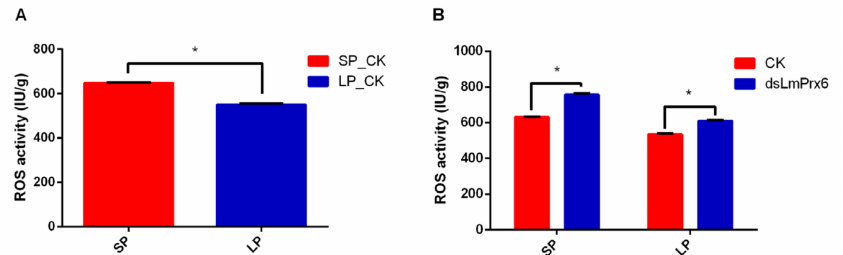
Figure 6. ( A ), ROS activity in the whole body of adult females under long and short photoperiods. ( B ), ROS activity detected in the whole body of adult females after injecting dsLmPrx6 under SP and LP. All results were expressed as means ± standard error (SE) of the three replicates.* Indicates probability level of p < 0.05 by Student’s t